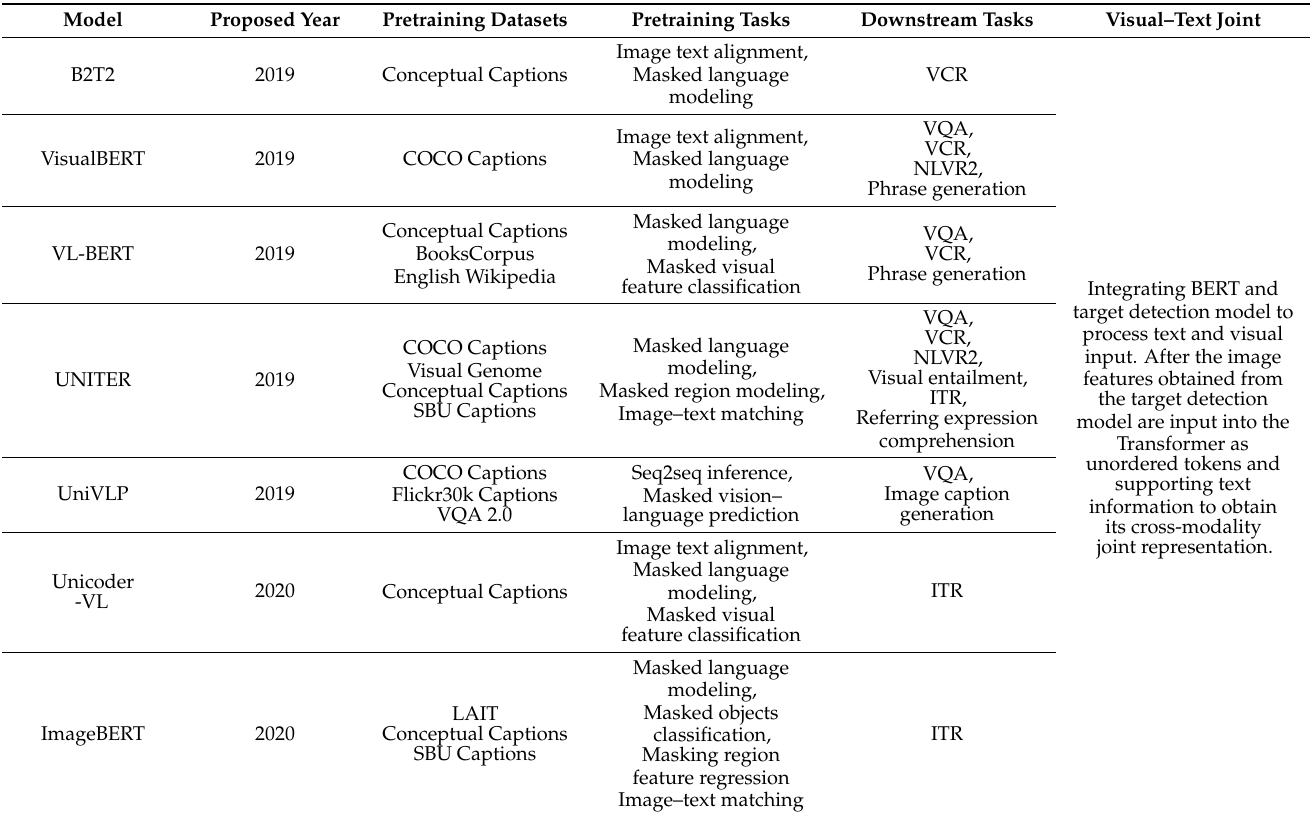
Table 4. Comparison of Regional Feature Image–Language Single Stream